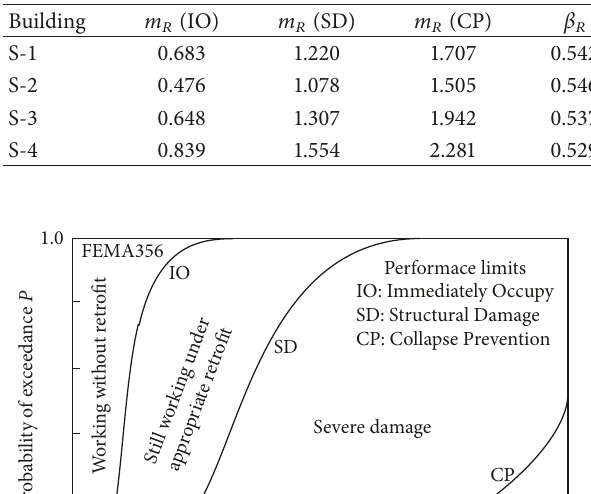
Figure 11: IDA curves of the building S-1 subjected to LA 10%/50yr. Table 4: Fragility parameters of the CFSF buildings.